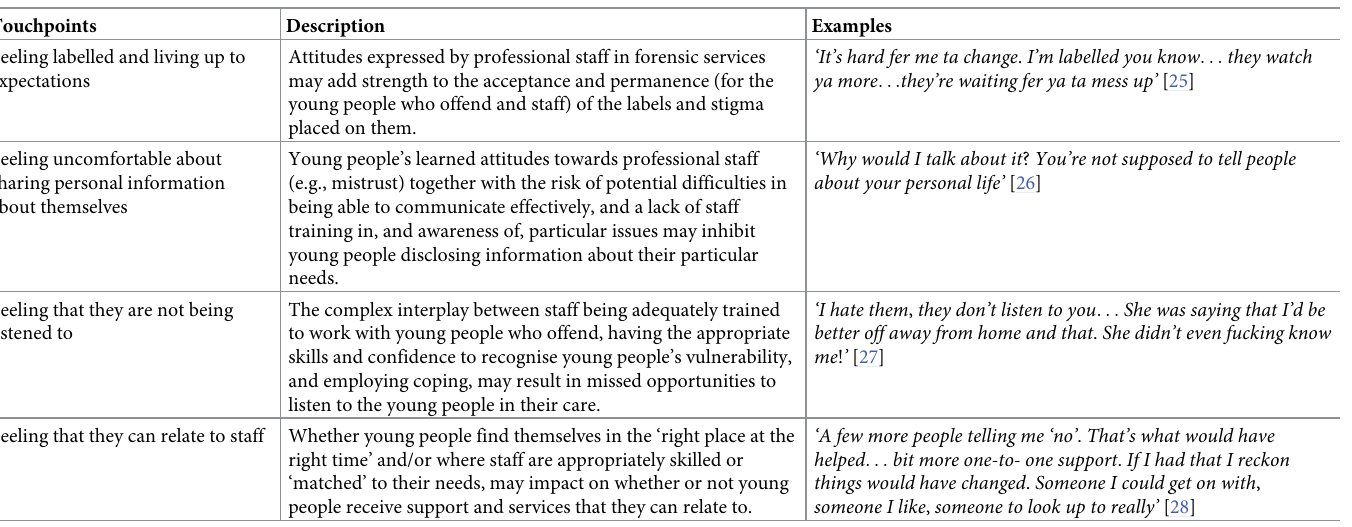
Table 1. Young people’s